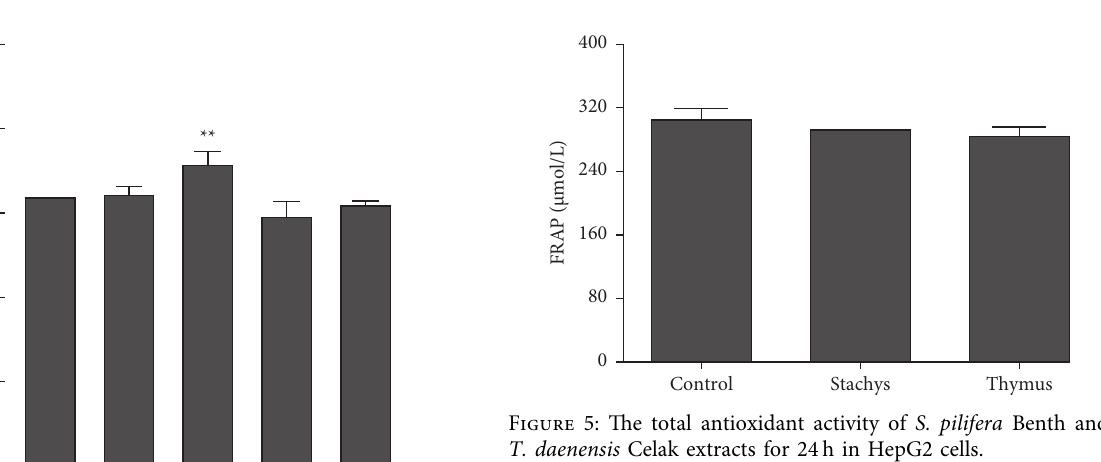
Figure 3: The apoptosis assay in HepG2 cells after treatment for 24h of different concentrations of (a) free media, (b) 100 µ g/mL and (c) 200 µ g/mL T. daenensis Celak extract, and (d) 75 µ g/mL and (e) 150 µ g/mL S. pilifera Benth extract. Q1 represents the necrosis cells, Q2 the late apoptosis cells, Q3 the cells in early apoptosis, and Q4 the viable cells.